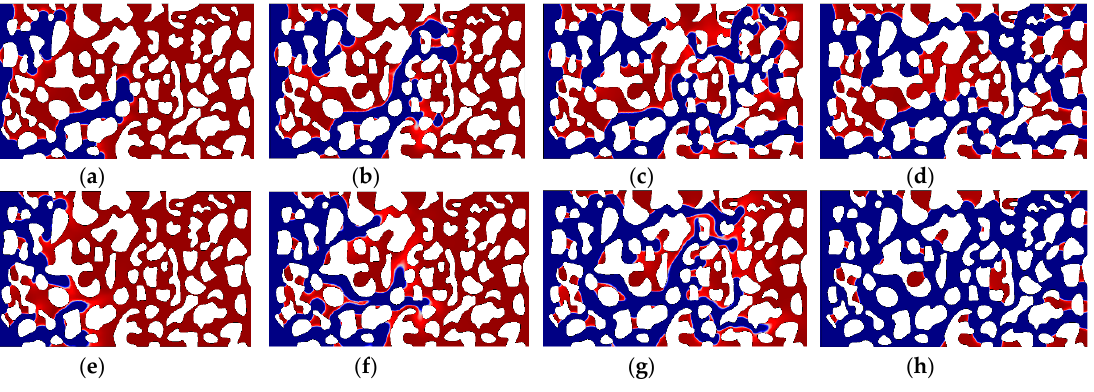
Figure 13. Displacement processes in water flooding and polymer flooding ( μ = 15 mPa·s): ( a ) water flood t = 0.002 s, ( b ) water flood t = 0.003 s, ( c ) water flood t = 0.0045 s, ( d ) water flood t = 0.04 s, ( e ) polymer flood t = 0.002 s, ( f ) polymer flood t = 0.003 s, ( g ) polymer flood t = 0.0045 s, and ( h ) polymer flood t = 0.04 s.